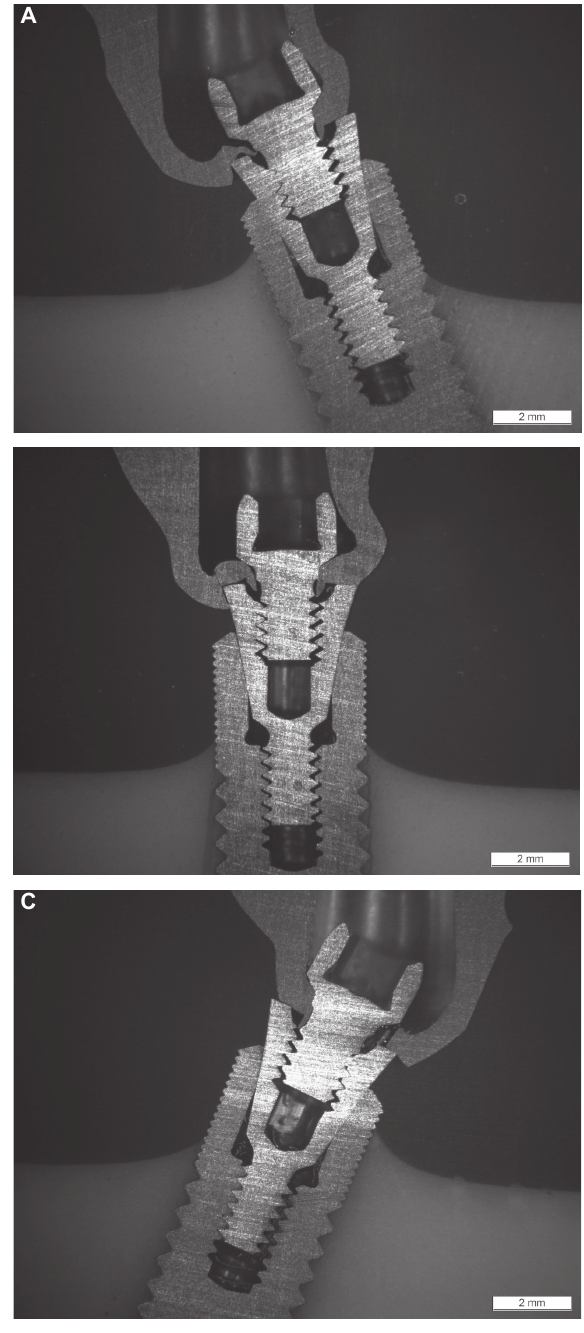
Figure 7 A-C- Polished cross-sections of embedded failed specimens of the differently angulated implants